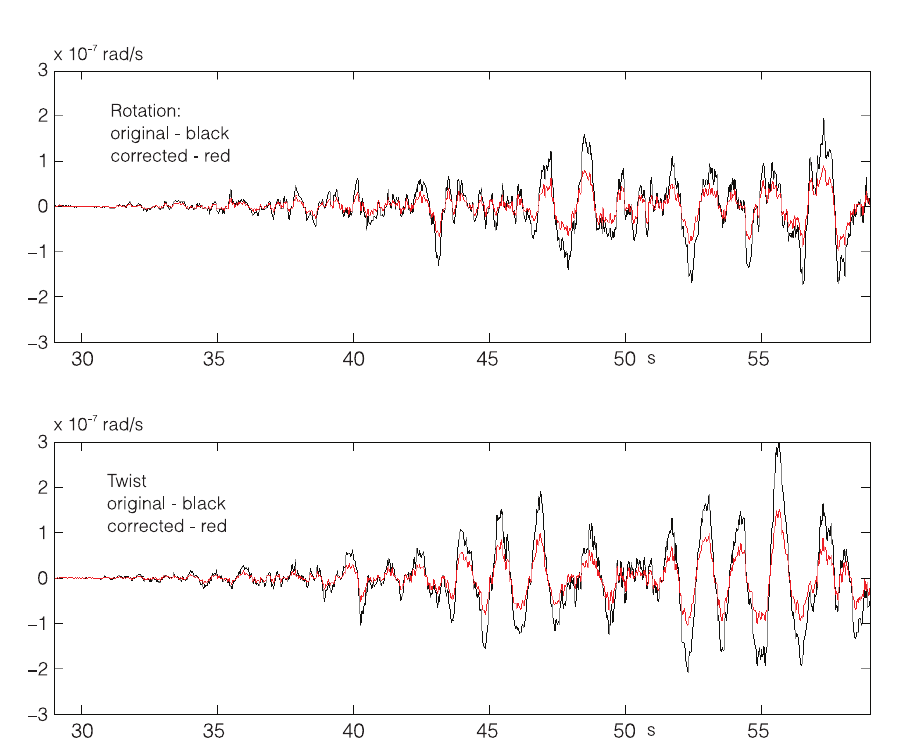
Fig. 10. Rotation and twist velocities derived from the records at L’Aquila Observatory of the 16 June 2002 seismic event in the Apennines; the black curves show the raw data, whereas the red ones show the corrected